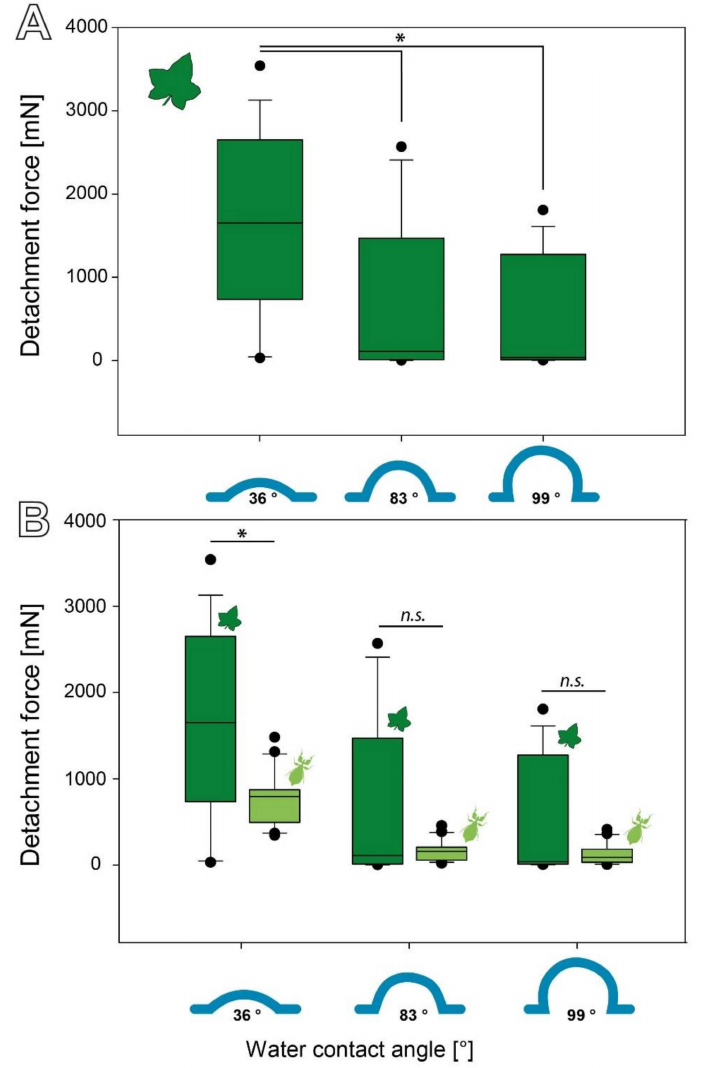
Figure 5. Influence of the surface wettability on the detachment forces. ( A ) Detachment force of Coccinia grandis seeds on substrates with different surface chemistry ( N = 15 per substrate) * p ≤ 0.05 (Kruskal–Wallis one-way ANOVA on Ranks). ( B ) Comparison of the detachment forces of seeds and eggs (N seeds = 15; N eggs = 20). n.s. = no statistical difference; * p ≥ 0.05; Mann–Whitney rank sum test). Boxes indicate the 25th and 75th percentiles, the line represents the median, and the whiskers are the 10th and 90th